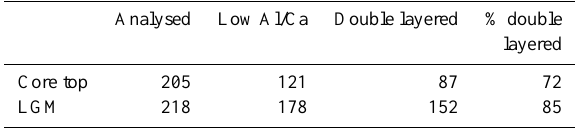
Table 2. Numbers of specimens analysed. Analysed Double